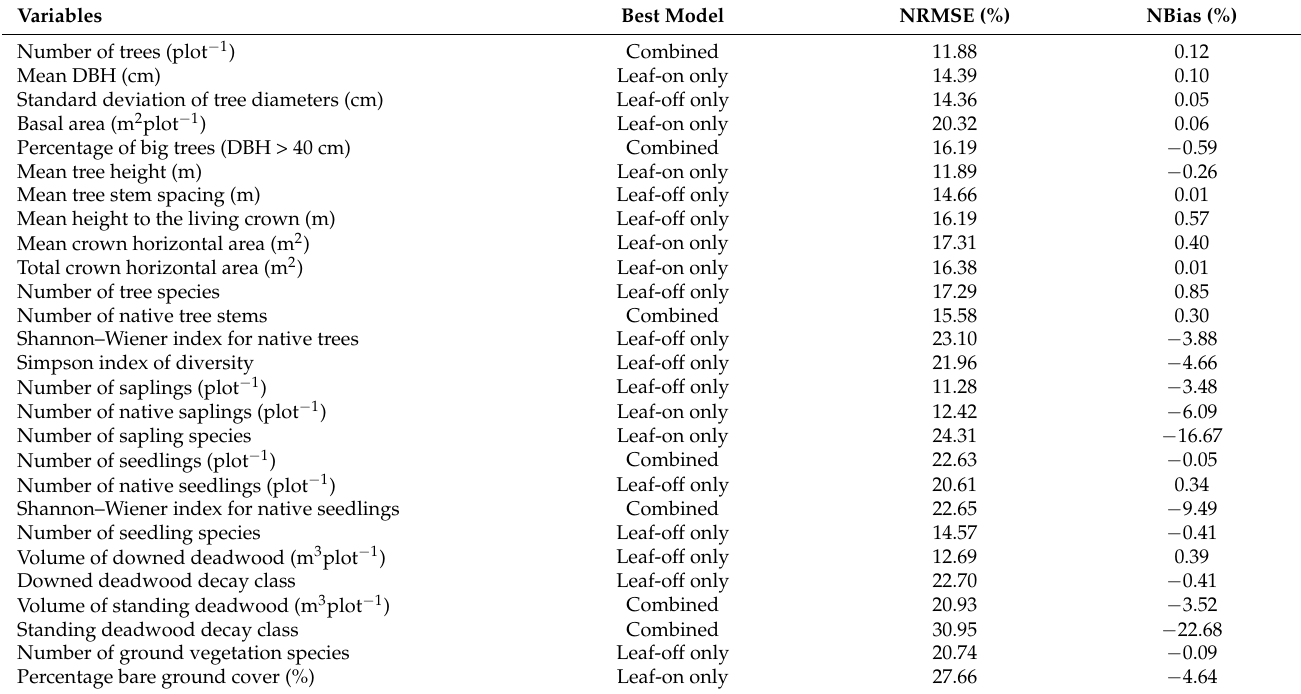
Table 5. Overall best models from leaf-on only, leaf-off only or combined leaf-on and leaf-off metrics (Combined). Model selection was determined by minimising RMSE/NRMSE and bias/NBias and maximising adj. R 2